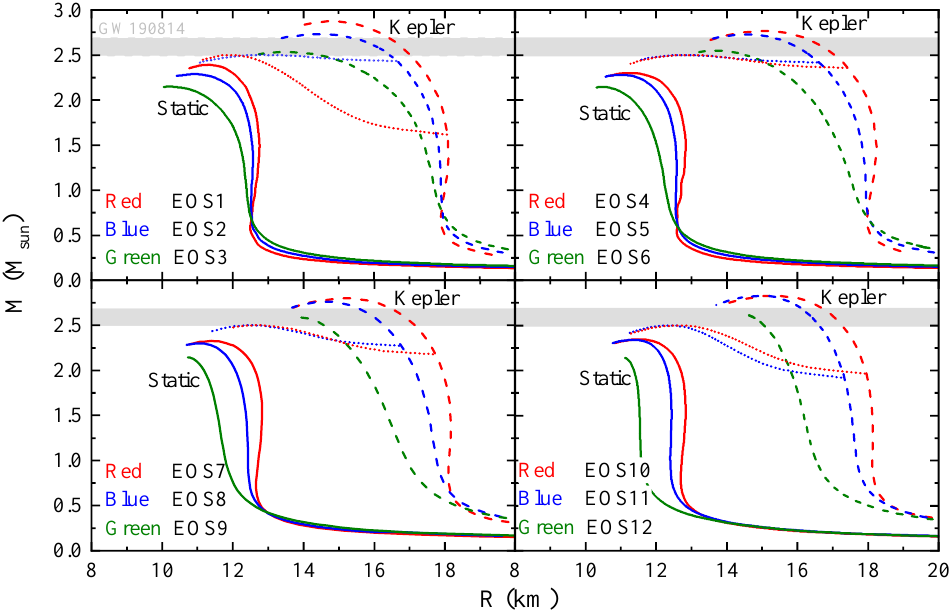
Figure 18. Mass–radius relations of both static (solid lines) and rotating neutron stars with the selected EOSs along the symmetry energy boundaries shown in the right window of Figure 4. The NSs rotating at the Kepler frequencies and minimum frequency that can rotationally support a NS with mass 2.5 M (cid:12) are shown as dashed and dotted lines, respectively. Taken from [42]. It is interesting to see that while the M TOV of the 12 EOSs are between 2.14 and 2.39 M (cid:12) , pulsars at their respective Kepler frequencies can easily sustain masses heavier than 2.50 M (cid:12) . For example, with the stiffest EOS possible (EOS1 with M TOV = 2.39 M (cid:12) ), the maximum rotating mass is 2.87 M (cid:12) , while with the soft EOSs including EOS3, EOS6, EOS9, and EOS12 on the right boundary of the allowed EOS space shown in Figure 4, the maximum rotating masses are slightly higher than 2.5 M (cid:12) , but less than 2.67 M (cid:12) . As the maximum mass of these EOSs is close to 2.5 M (cid:12) , f 2.5 is slightly lower than the Kepler frequency; thus, the RNS code [169] does not output the f 2.5 for EOS3, EOS6, EOS9, and